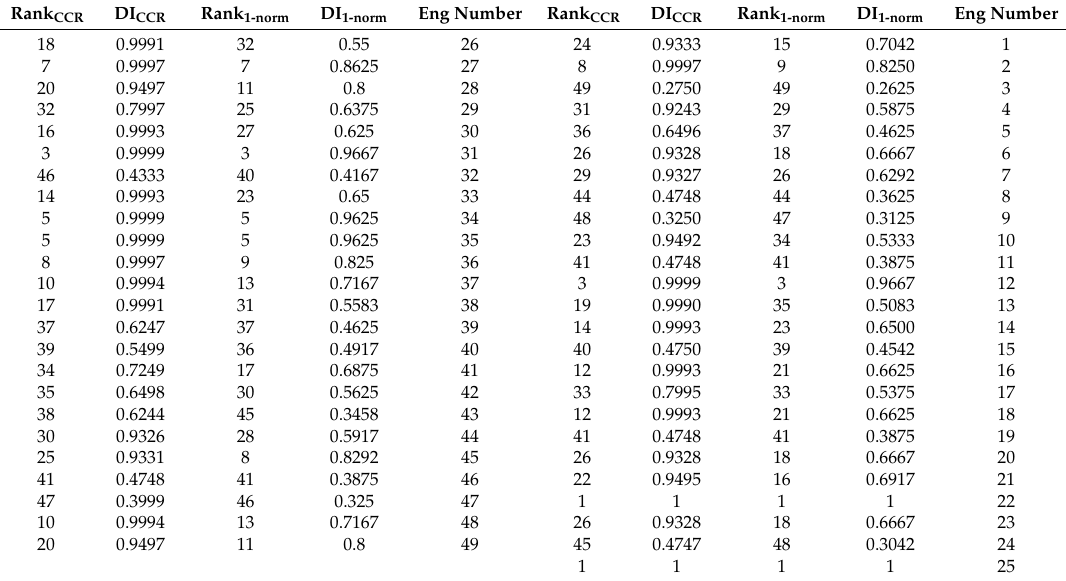
Table 4. Engineer leadership efficiency and ranking